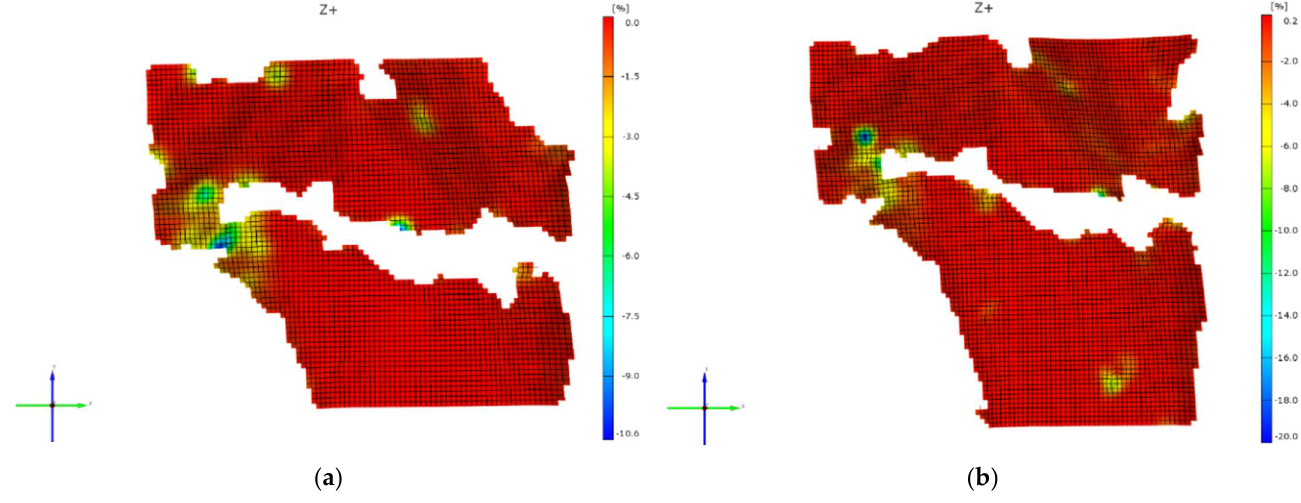
Figure 9. Values of the minor strain ε 2 during Fujisawa point loading ( a ) and medial loading ( b ).